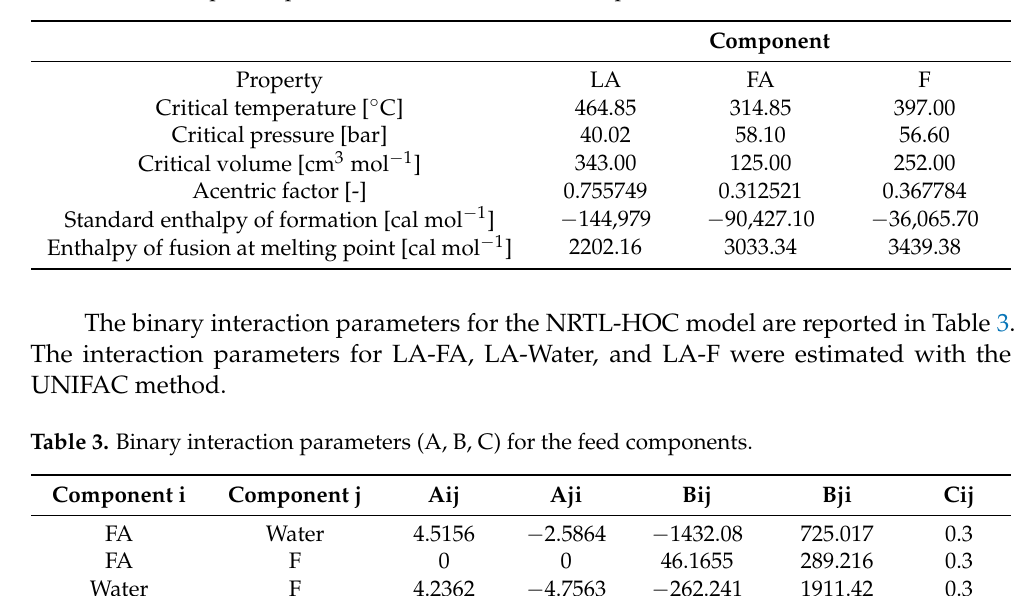
Table 2. Pure component parameters retrieved from the Aspen database.